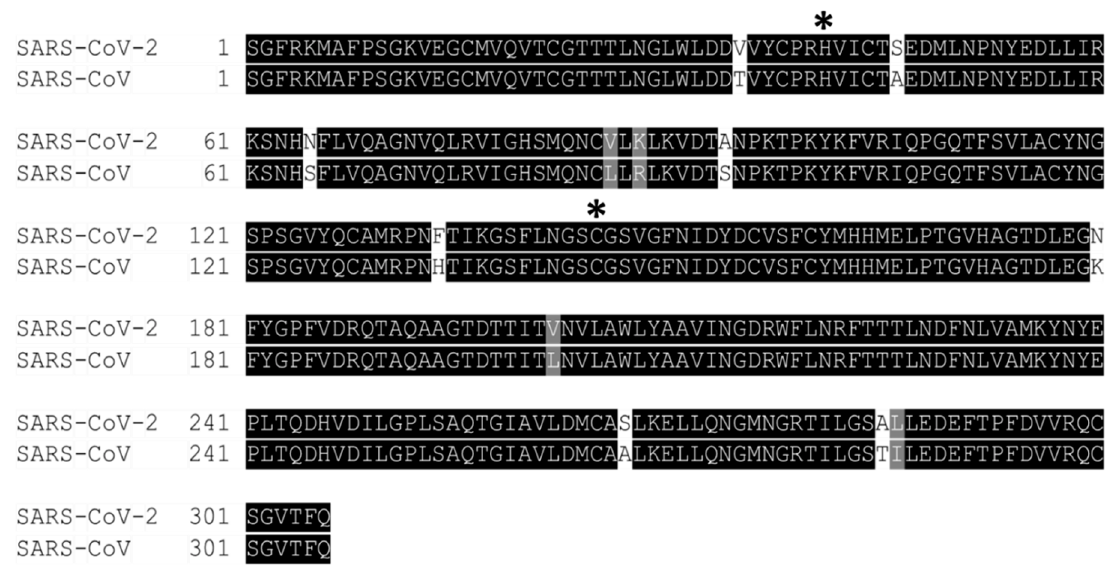
Figure 4. Multiple sequence alignment of 3CLpro between SARS-CoV-2 and SARS-CoV revealed that the sequences shared 96% sequence identity. The asterisk ( * ) indicates the shared catalytic residues of histidine (H) and cysteine (C). The non-conserved residues were in white or grey colour. Meanwhile, the conserved residues were highlighted in black colour.